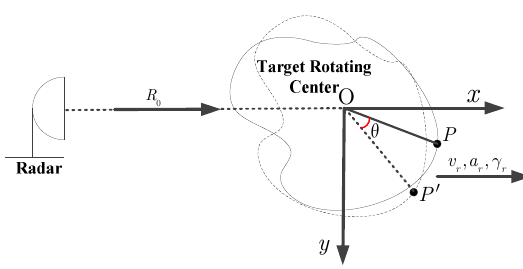
Figure 1. Inverse synthetic aperture radar (ISAR) imaging geometric model of a maneuvering